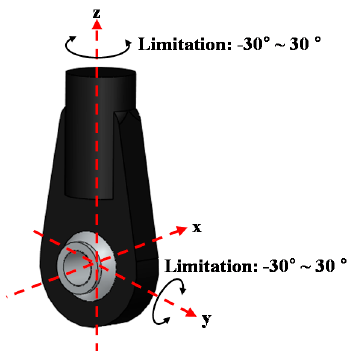
Figure 8. Limitation of spherical joint.